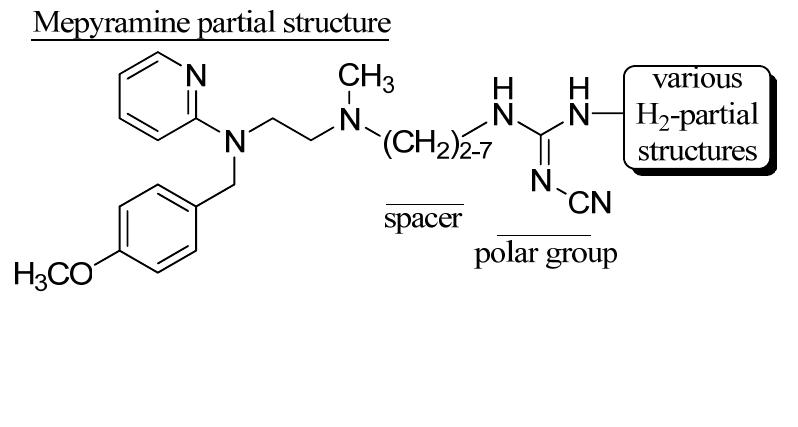
Figure 2. General structure of spacer-linked combined H